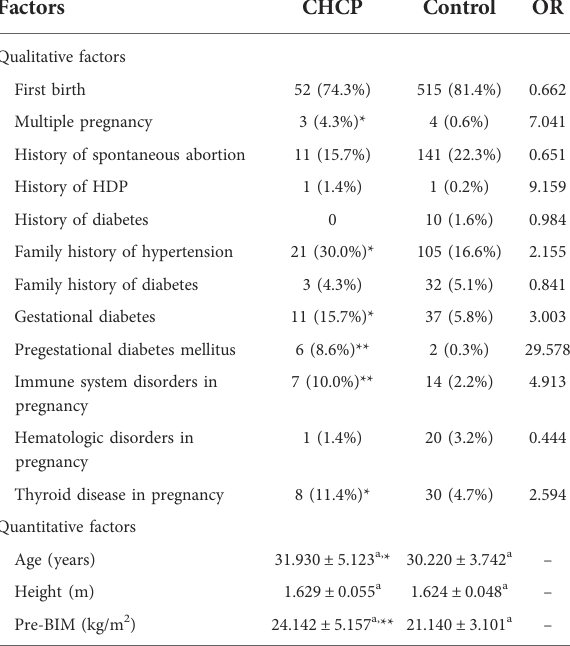
TABLE 7 Static factors analysis of chronic hypertension complicated with preeclampsia.